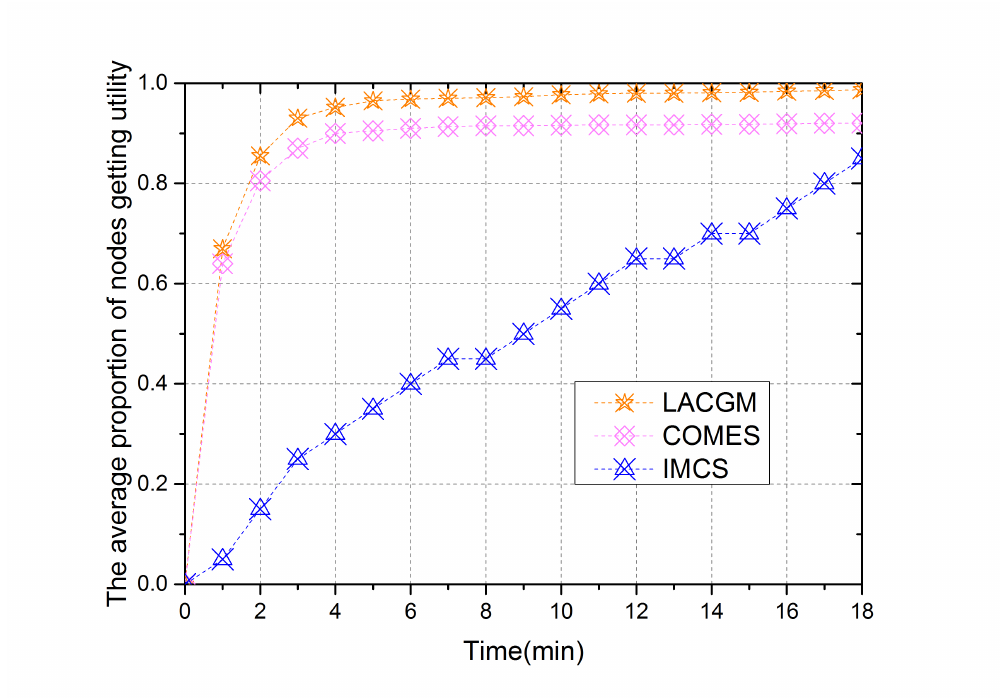
Figure 8. Average node utility changing with time ( Υ = 400, N =